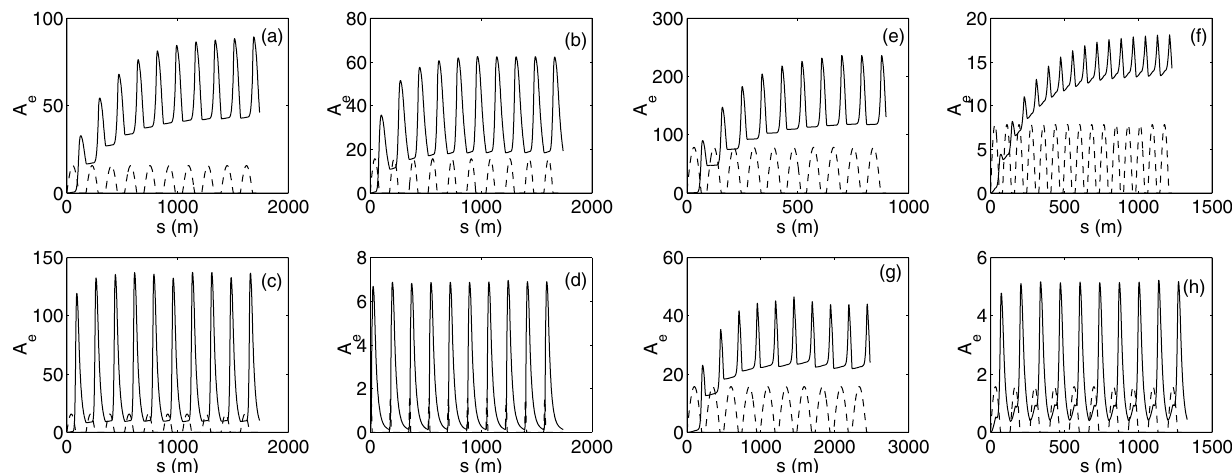
FIG. 2. Electron amplification factor. The proton beam profiles are plotted by the dashed lines in the pictures with arbitrary units. Electrons are produced at the chamber surface. (a) 3 GeV injection; (b) 3 GeVextraction; (c) 50 GeV injection; (d) 50 GeVextraction; (e) PSR; (f) ISIS; (g) SNS; (h) AGS.